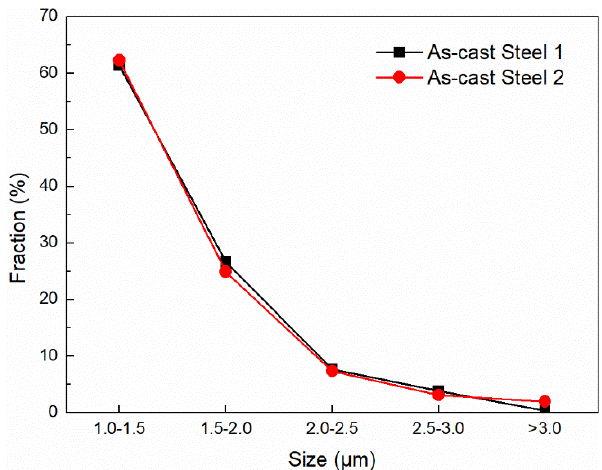
Figure 3. Size distribution of inclusions in as-cast steels.